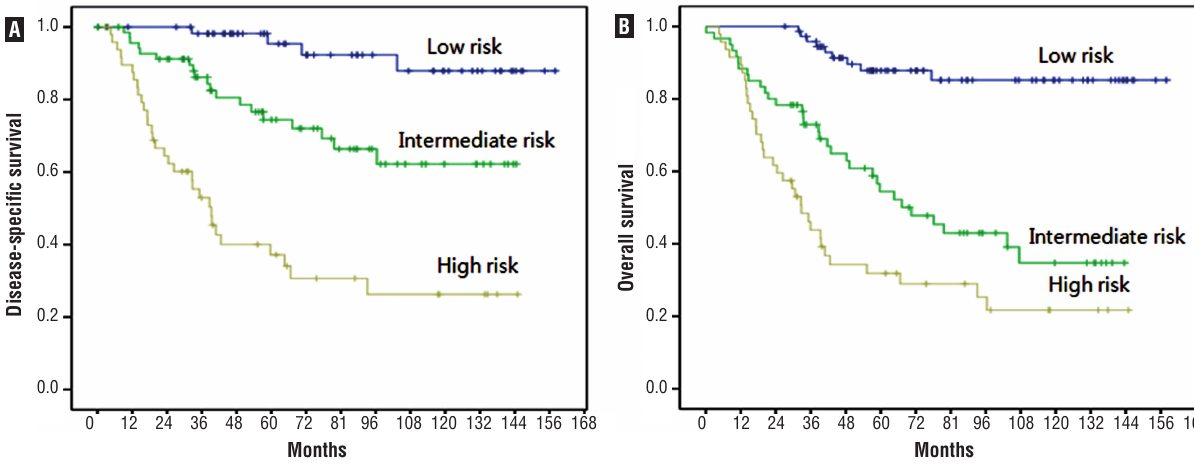
Figure 2 - (A) Kaplan-Meier plots of disease-specific survival of the Cox regression mode (p <0.0001). (B) Kaplan-Meier plots of overall survival of the Cox regression mode (p